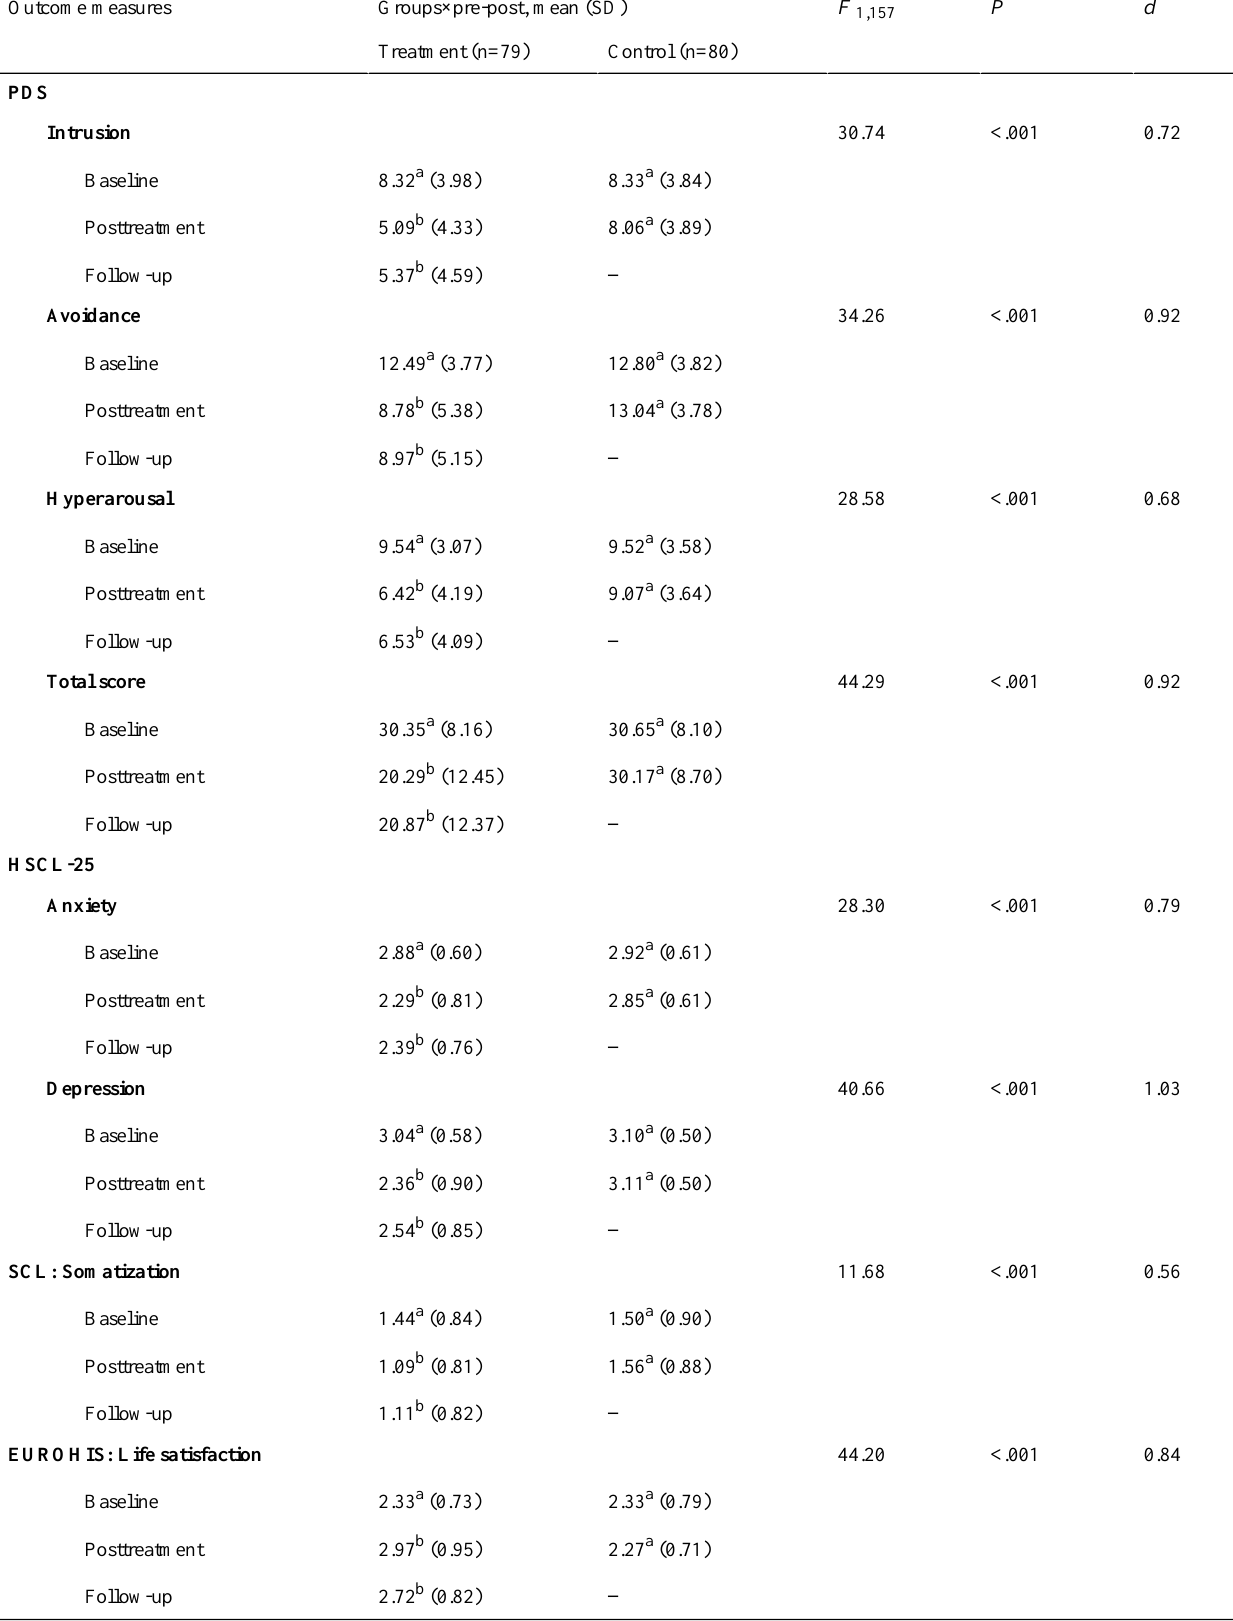
Table 2. Results of mixed design ANOVAs for the treatment and waiting list control groups at baseline, posttreatment, and 3-month follow-up: intention-to-treat